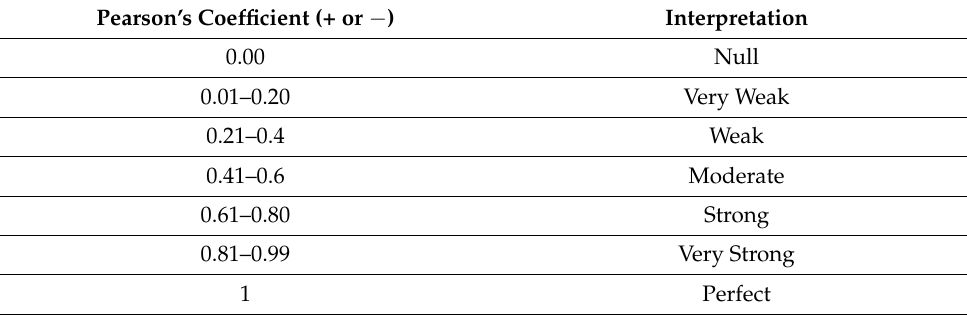
Table 1. Reliability rating of Pearson’s correlation coefficient